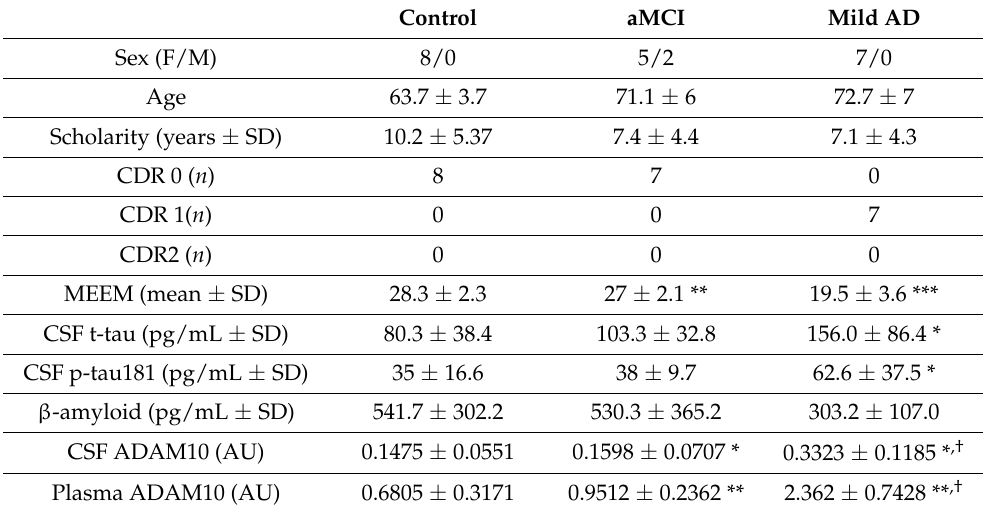
Table 1. Sociodemographic, clinical variables and neuropsychological evaluations of subjects in the